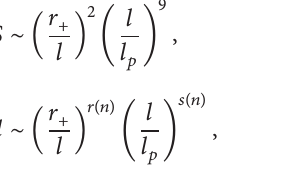
is the Planck scale in 11 dimensions [8, 9]. The